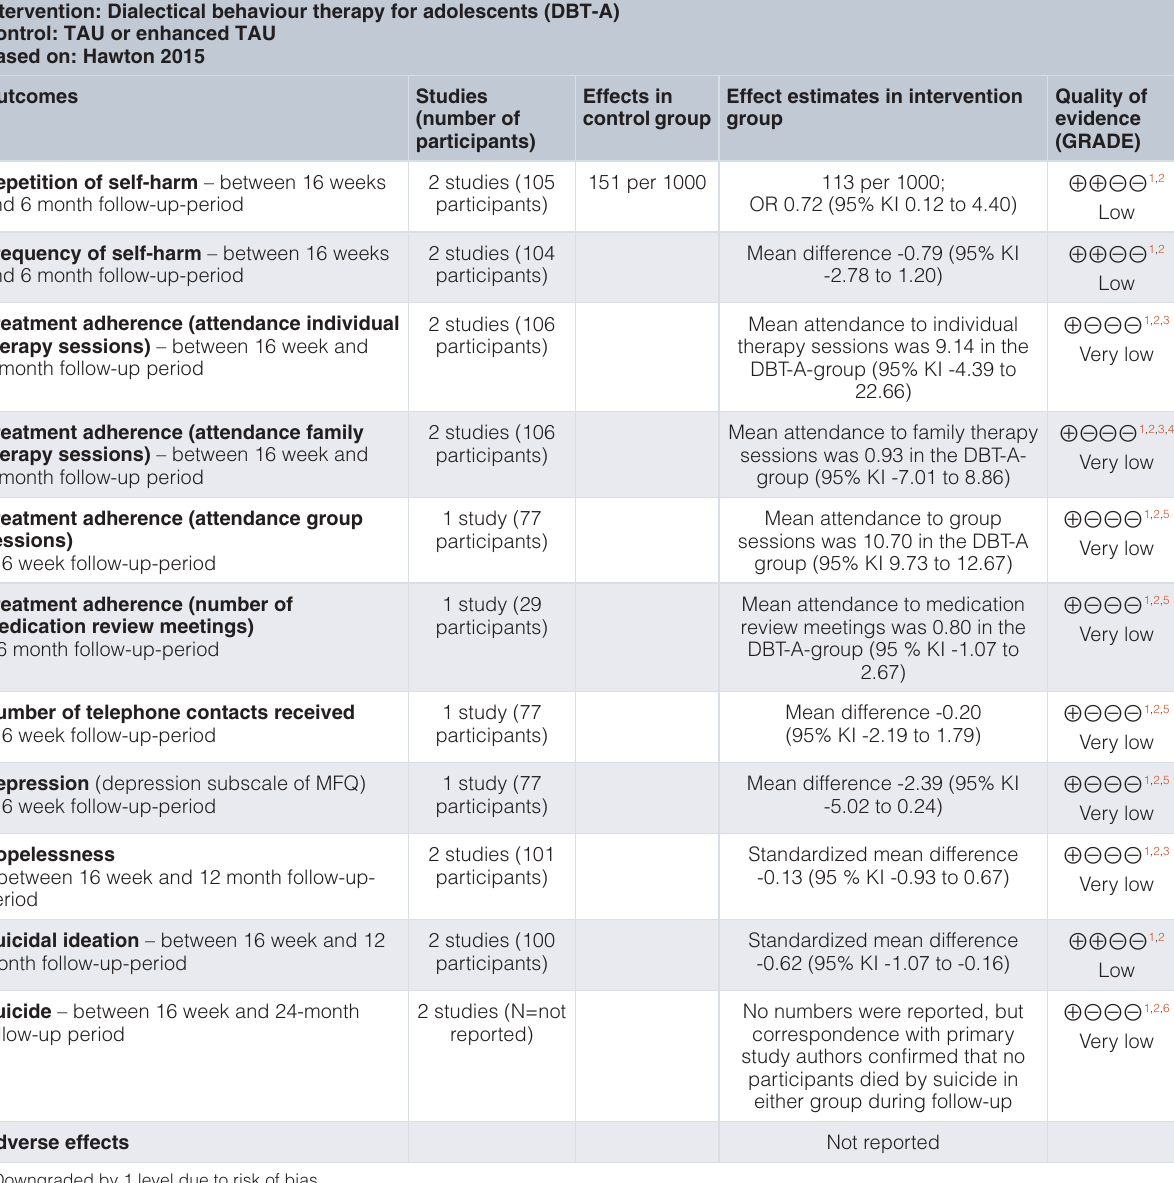
Table 9. GRADE-assessment: Interventions for existing self-harm: dialectical behaviour therapy adapted for adolescents (DBT-A) versus treatment as usual (TAU) or enhanced TAU. Population: Adolescents, 12 to 19-year olds, with a history of multiple episodes of self-harm Intervention: Dialectical behaviour therapy for adolescents (DBT-A)